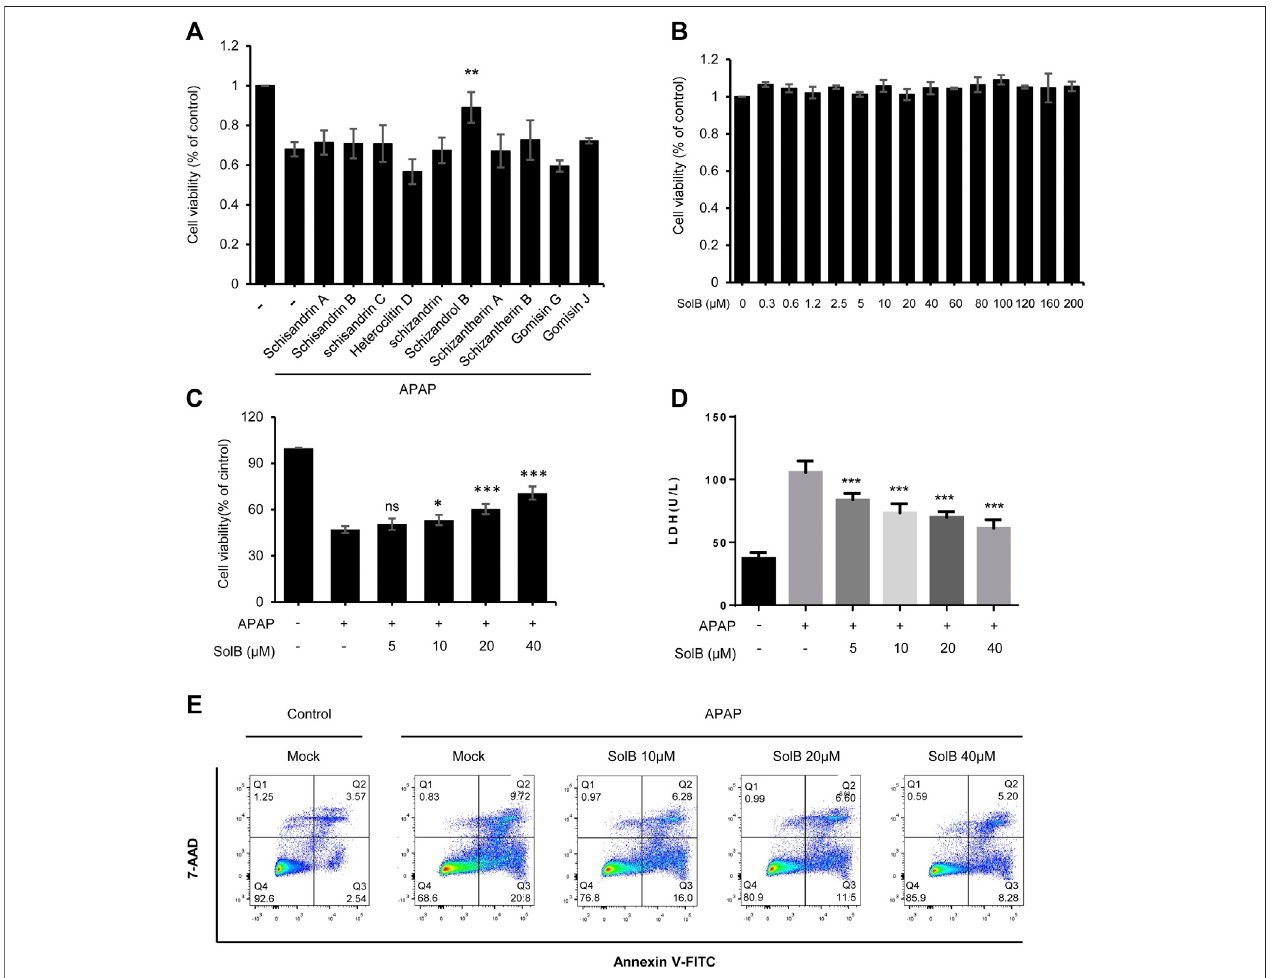
FIGURE 1 | SolB signi fi cantly inhibited hepatocyte injury in vitro (A) The effect of the constituents of Schisandra sphenanthera on APAP-induced hepatocyte injury (B) Cell viability ofL02 cells treated withSolB for24 hwere detected (C,D) Survivalrateby CCK-8 (C) and the release of LDH (D) ofL02 cells treated with SolB and then exposedtoAPAP (E) EarlyapoptoticofL02cellsweretreatedwithSolBandthenexposedtoAPAP,anddetectedbyFlowcytometry.DataareexpressedasMean ± SD from three biological replicates ( n (cid:2) 3). Statistics differences were analyzed using One-way ANOVA followed by Dunnett ’ s test:* p < 0.05, ** p < 0.01, *** p < 0.001; NS, no signi fi